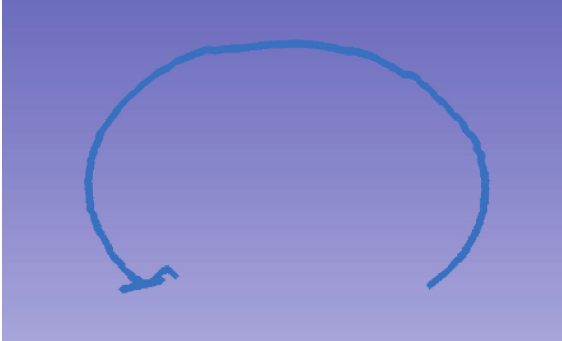
Figure 19: Laser tracker sampling trajectory by prototype